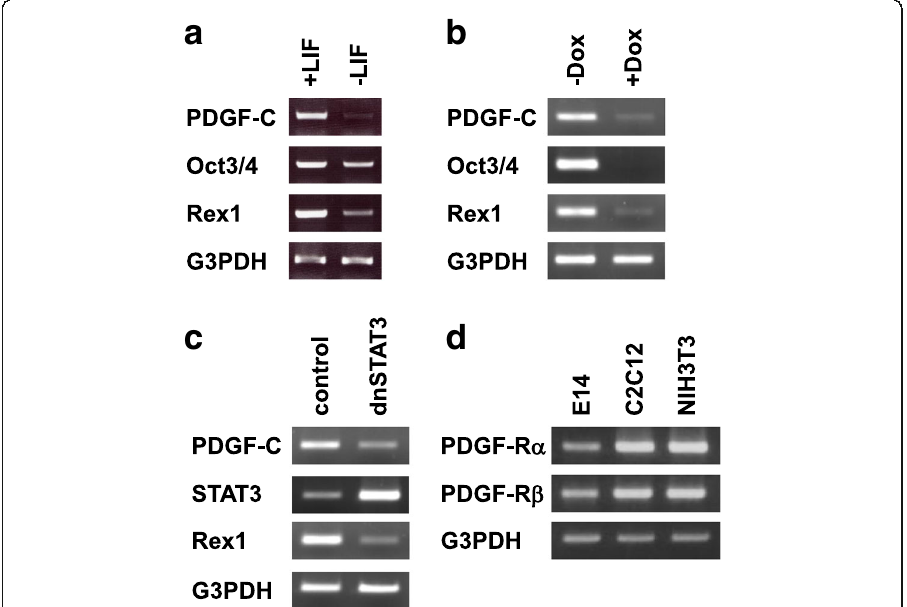
Fig. 3 PDGF-C is expressed in self-renewing ES cells and downregulated during ES cell differentiation. a Reduction of PDGF-C mRNA expression by LIF depletion. After culture with LIF for 3 days (+LIF) or without LIF for 6 days ( − LIF), the expression levels of PDGF-C, Oct3/4 and Rex1 in the E14 ES cells were examined using RT-PCR. b The reduction in PDGF-C mRNA expression by Oct3/4 depletion. ZHBTc4 ES cells were cultured with (+) or without ( − ) doxycycline (Dox) for 2 days. Expression of the indicated genes was examined by RT-PCR. c Reduction of PDGF-C mRNA expression by the expression of a dominant-negative mutant of STAT3. After transfection with pCAG-IP (control) or pCAG-dnSTAT3-IP (dnSTAT3), E14 ES cells were cultured with puromycin for 2 days. Expression of the indicated genes was examined using RT-PCR. d Expression of PDGF receptors in ES cells. Total RNA was prepared from E14 ES cells, C2C12 myoblasts and NIH3T3 fibroblasts and subjected to RT-PCR. In all experiments, the results shown are representative of three independent [25], Dox-stimulated Oct3/4 repression led to a dramatic decrease in PDGF-C expression